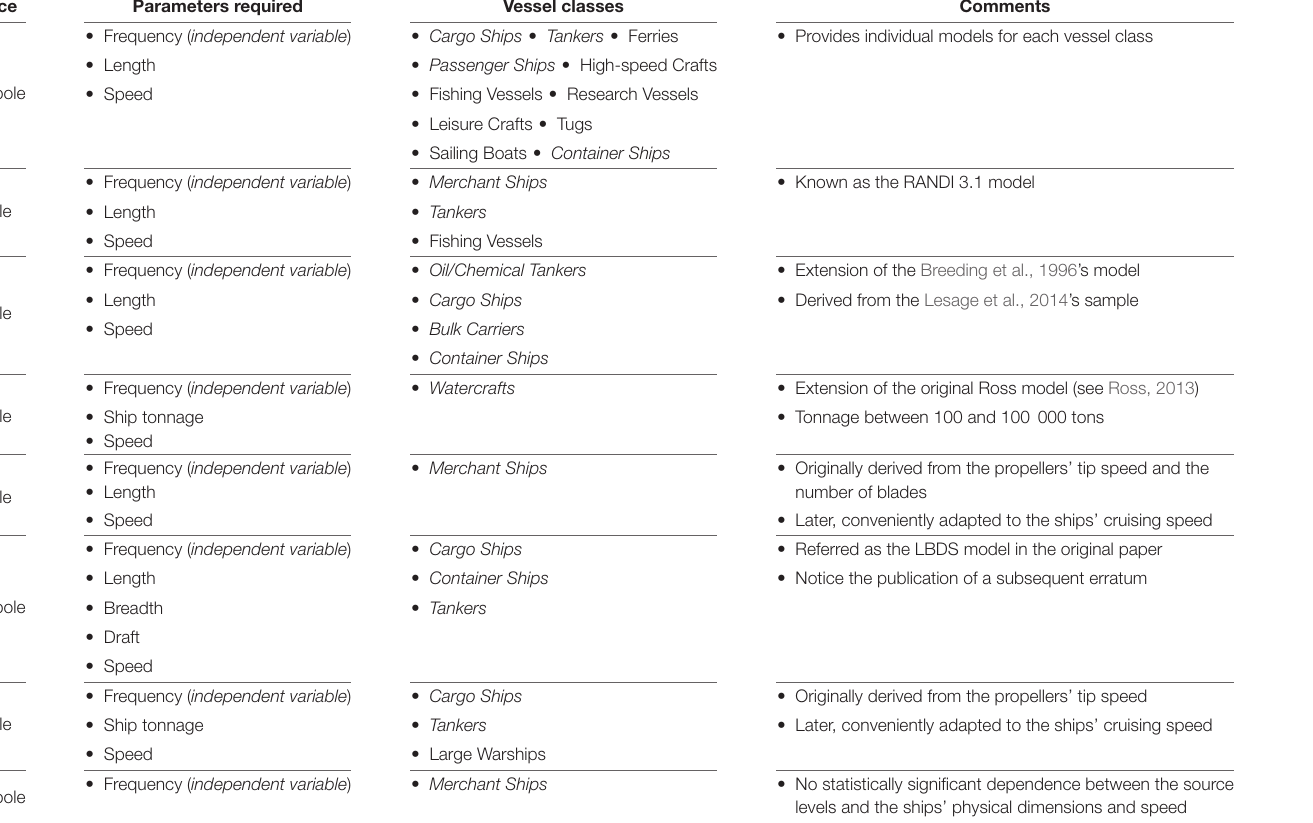
TABLE 5 | Details of the theoretical models published in the literature that serve as RNL/MSL predictors. Selected